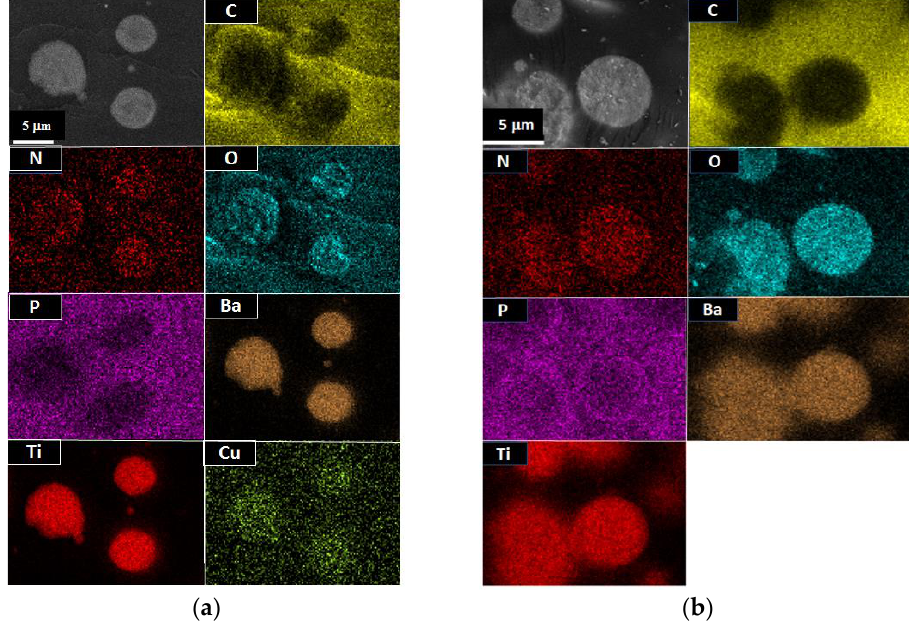
Figure 5. ( a ) EDX mapping of EP-4; ( b ) SEM micrographs of epoxy thermosets heated up to 700 °C, with the heating rate of 10 °C/min, under nitrogen atmosphere.